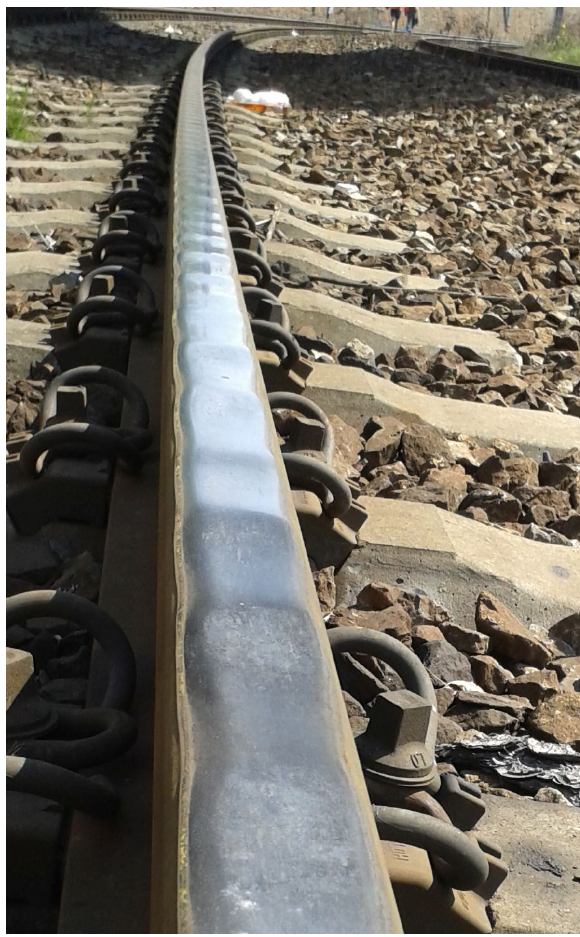
Figure 1. Long-pitch corrugation in Havlíčkův Brod